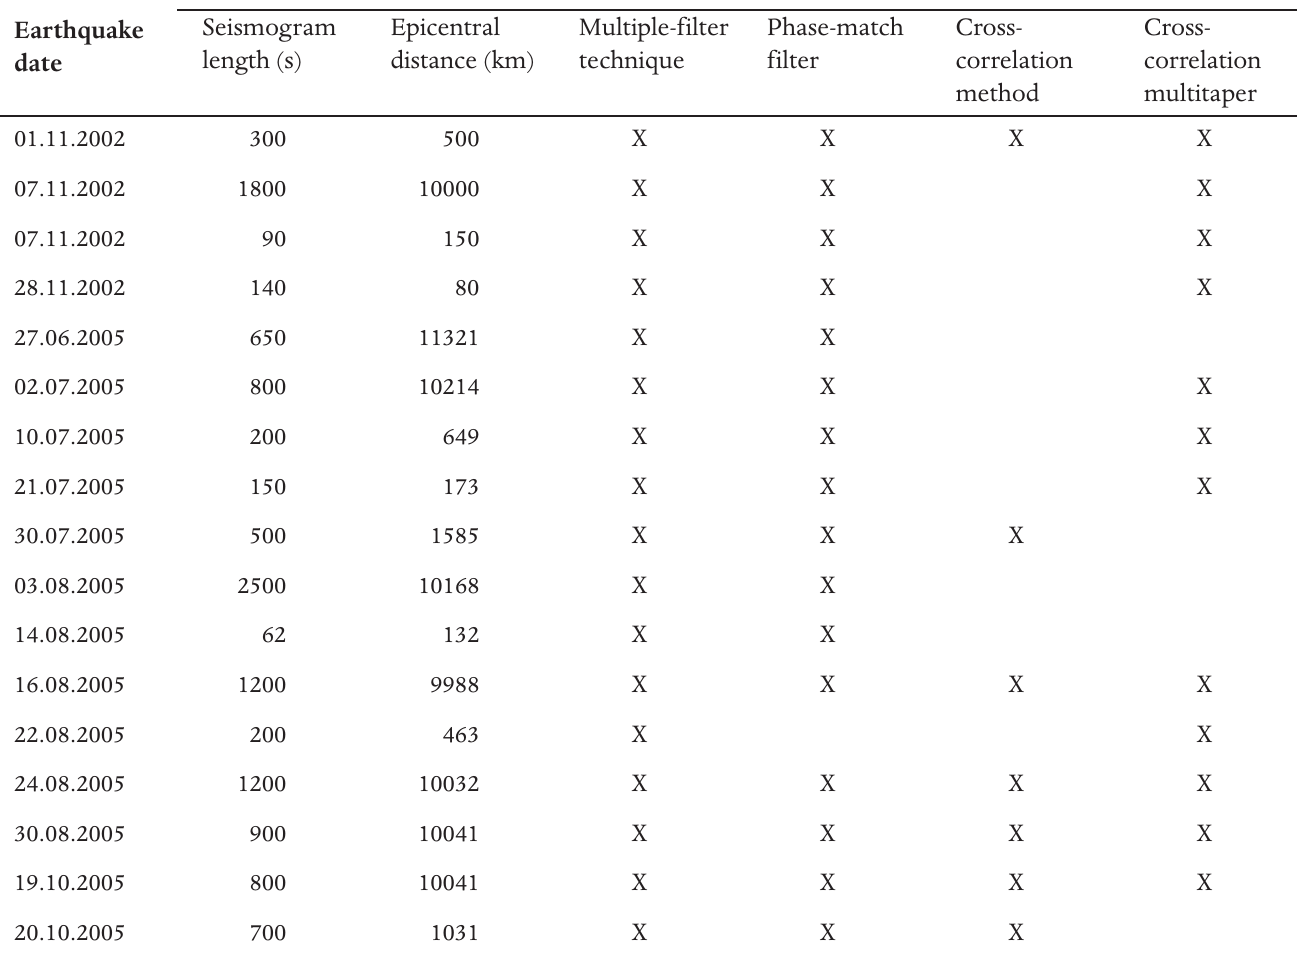
Table 1. Analyzed earthquakes according to successful application of dispersion